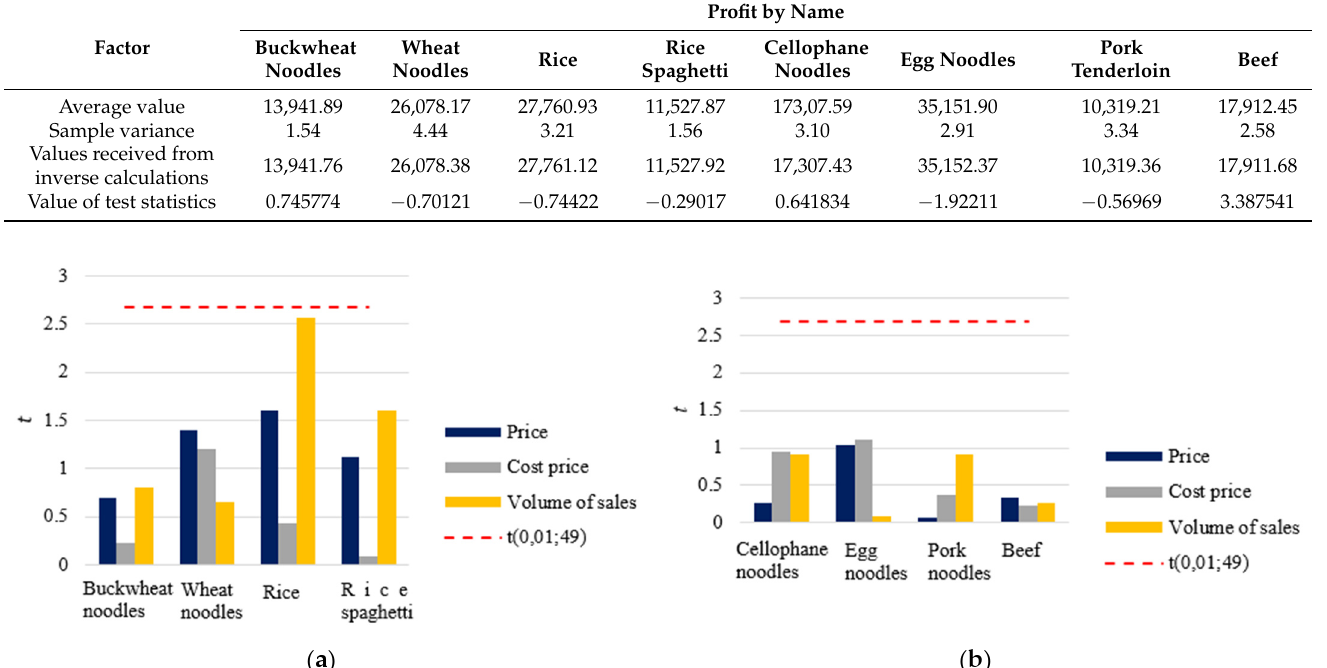
Figure 14. Change in product profit as a function of the number of realizations. Table 6. Statistical values of Student ′ s t- test.